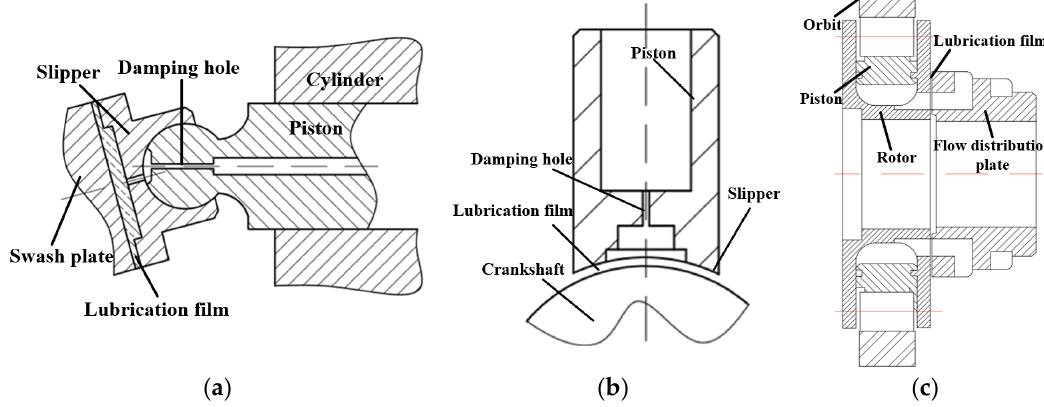
Figure 1. The schematic of key friction pairs in water-based motor/pump: ( a ) slipper–swash plate; ( b ) slipper crankshaft friction pair; ( c ) the flow distribution of the plate–rotor friction pair.